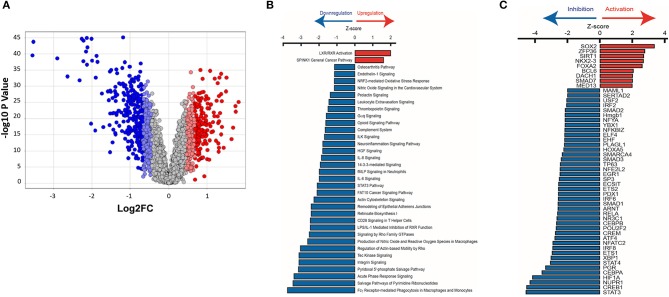
Ingenuity pathway analysis of mRNA microarray data obtained from HCM patient myectomy tissue compared to control (healthy donor) heart tissue. (A) This volcano plot represents the ANOVA results of HCM vs. controls, depicting genes' log2 fold changes on the X-axis and their –log10
P-values on the Y-axis. Each dot in the figure represents a gene and is colored according to the standard deviation (SD) of that gene's log fold change from the mean. Genes with greater than 2SD up or down were used in the IPA analysis. (B) IPA identified pathways that are significantly (P < 0.032) up-regulated (Z-score > 0) or down-regulated (Z-score < 0) in HCM patients compared to control subjects. (C) Identification of upstream transcriptional regulators that are upregulated and downregulated in HCM patients compared to control subjects.